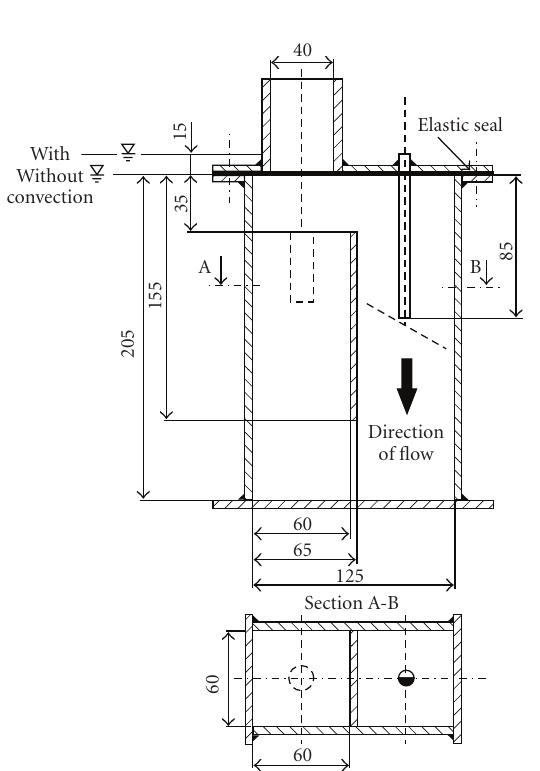
Figure 2: Schematic illustration of the tensi impeller-driven agitation device used in ASTM